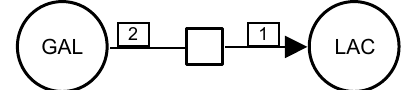
Figure 2.28: Conversion of two galactoses into a